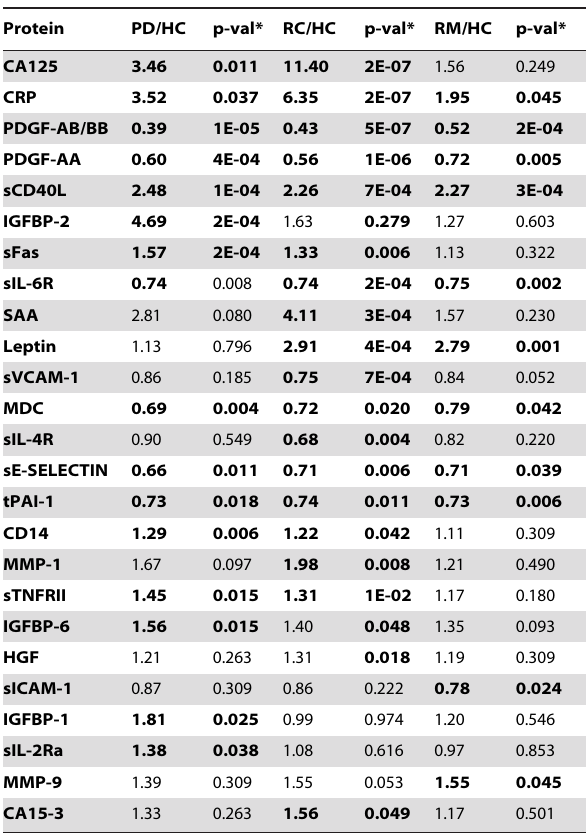
Table 2. Significant changes in serum protein levels in patients as compared to healthy controls (PD: Post Diagnosis, HC: Healthy Controls, RC: Recurrence, RM: